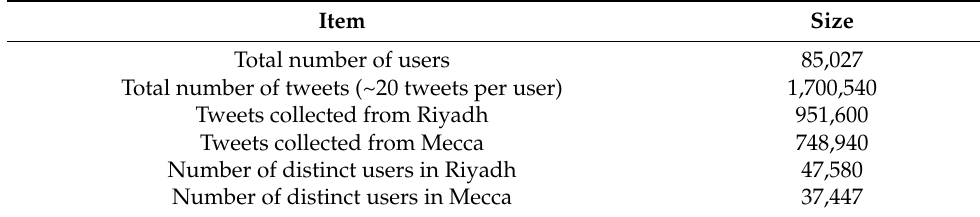
Table 1. Statistics of the data before